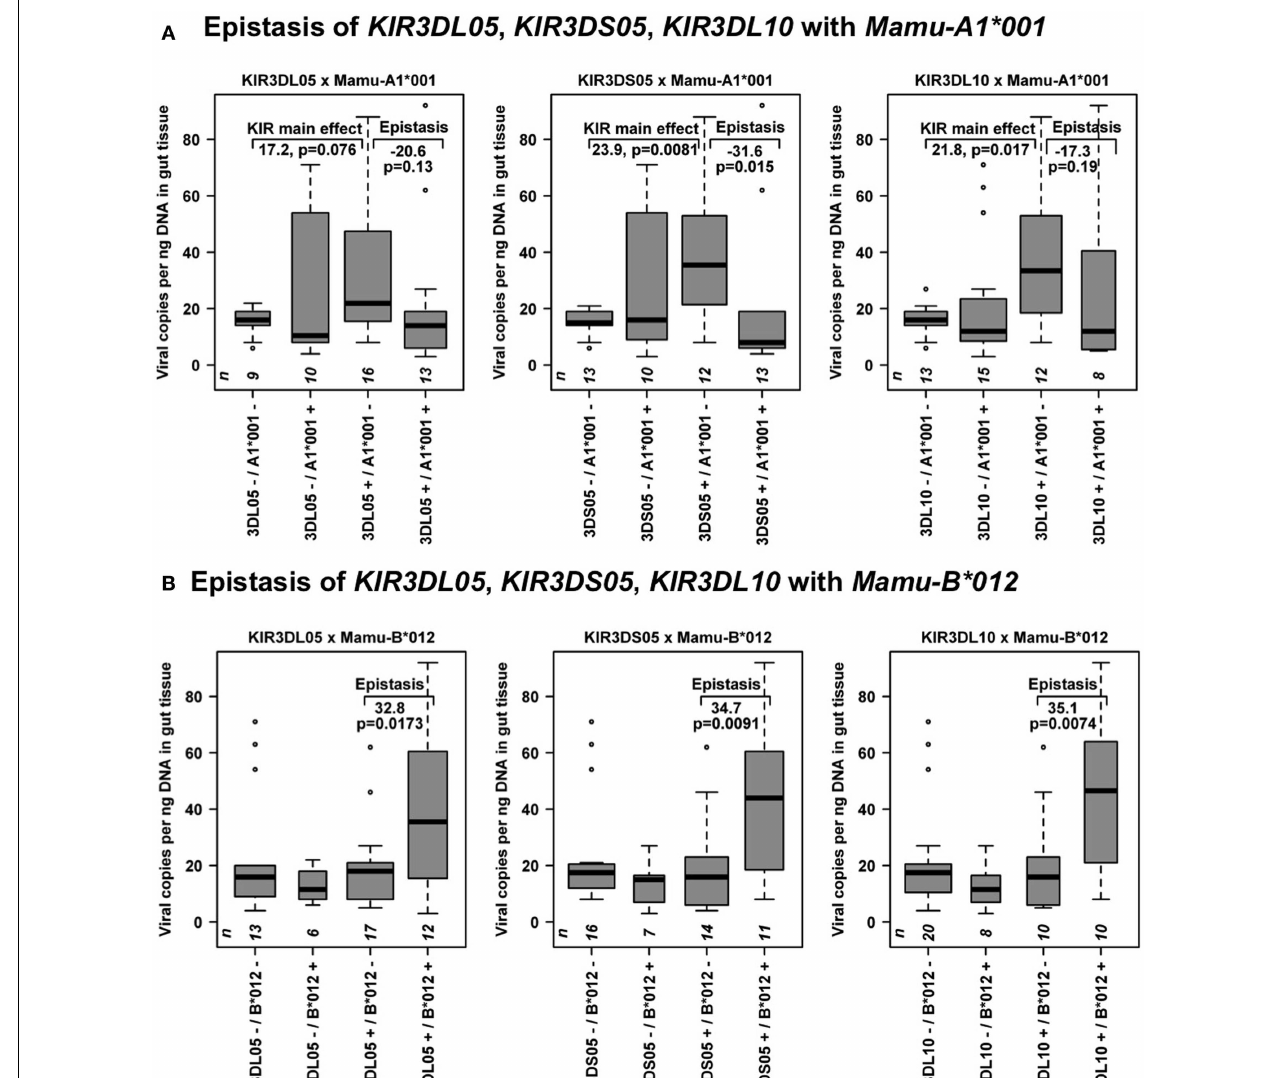
FIGURE 5 | Epistasis of the correlated KIR3DL05 – KIR3DS05 – KIR3DL10 genes with Mamu-A1*001 and Mamu-B*012 on viral copy numbers in GIT .The boxplots of viral copy numbers stratify for presence ( + ) and absence ( − ) of Mamu-A1*001 or Mamu-B012 and the respective KIR (left panels: KIR3DL05 , middle panels: KIR3DS05 , right panels: KIR3DL10 ) transcripts. Sample sizes n are displayed at the bottom of the graphs. (A) Illustrated